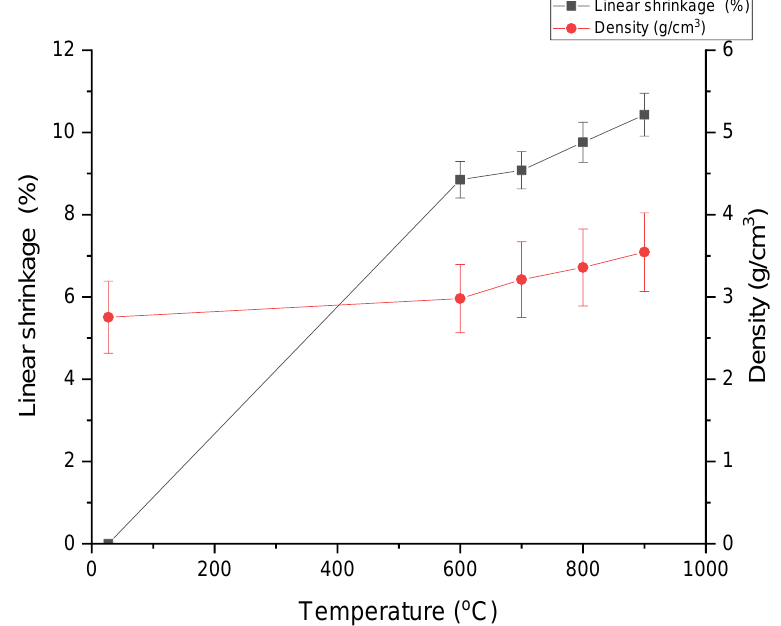
Figure 1. The linear shrinkage percentage and the density of the 55ZnO–5B 2 O 3 –40SLS glass and glass-ceramic sample at a various heat-treatment temperatures.